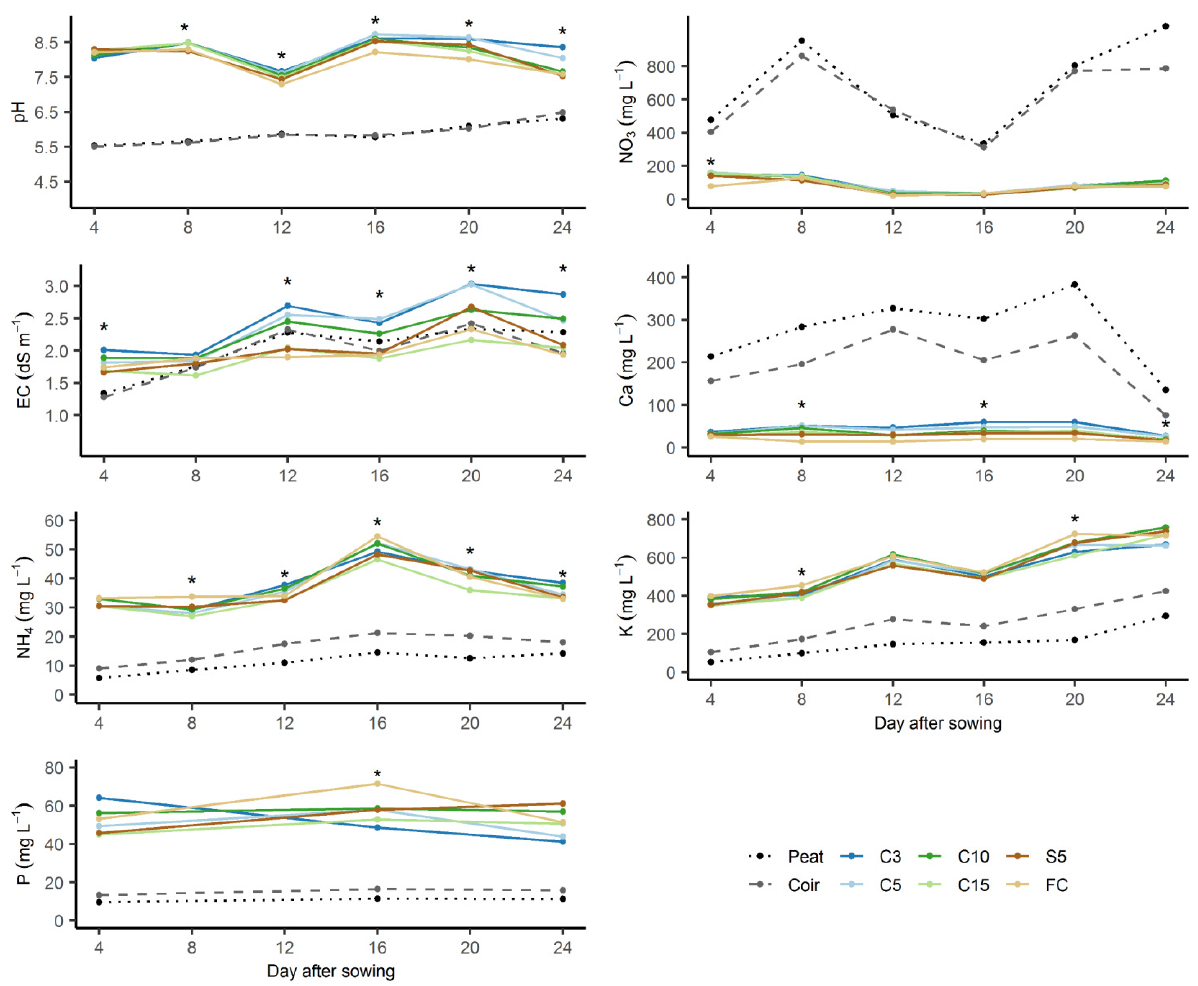
Figure 9. The pH, EC and water-soluble nutrients concentration in the extract substrate solution (saturation method). For each substrate, one data point represents for the mean of 4 replicates (each replicate consists of 3 sowing cells without having plants). Miscanthus × giganteus was harvested with a forage harvester (FC, field-chips), then processed with a mechanical fraying facility through a 5-mm screen (S5, shreds) or a hammermill with screen sizes of 15, 10, 5, and 3 mm (C15, C10, C5, and C3, chips). The asterisks represent for significant differences among tested growing media and different letters (A Tukey’s HSD, p ≤ 0.05), details are given in Table S3.